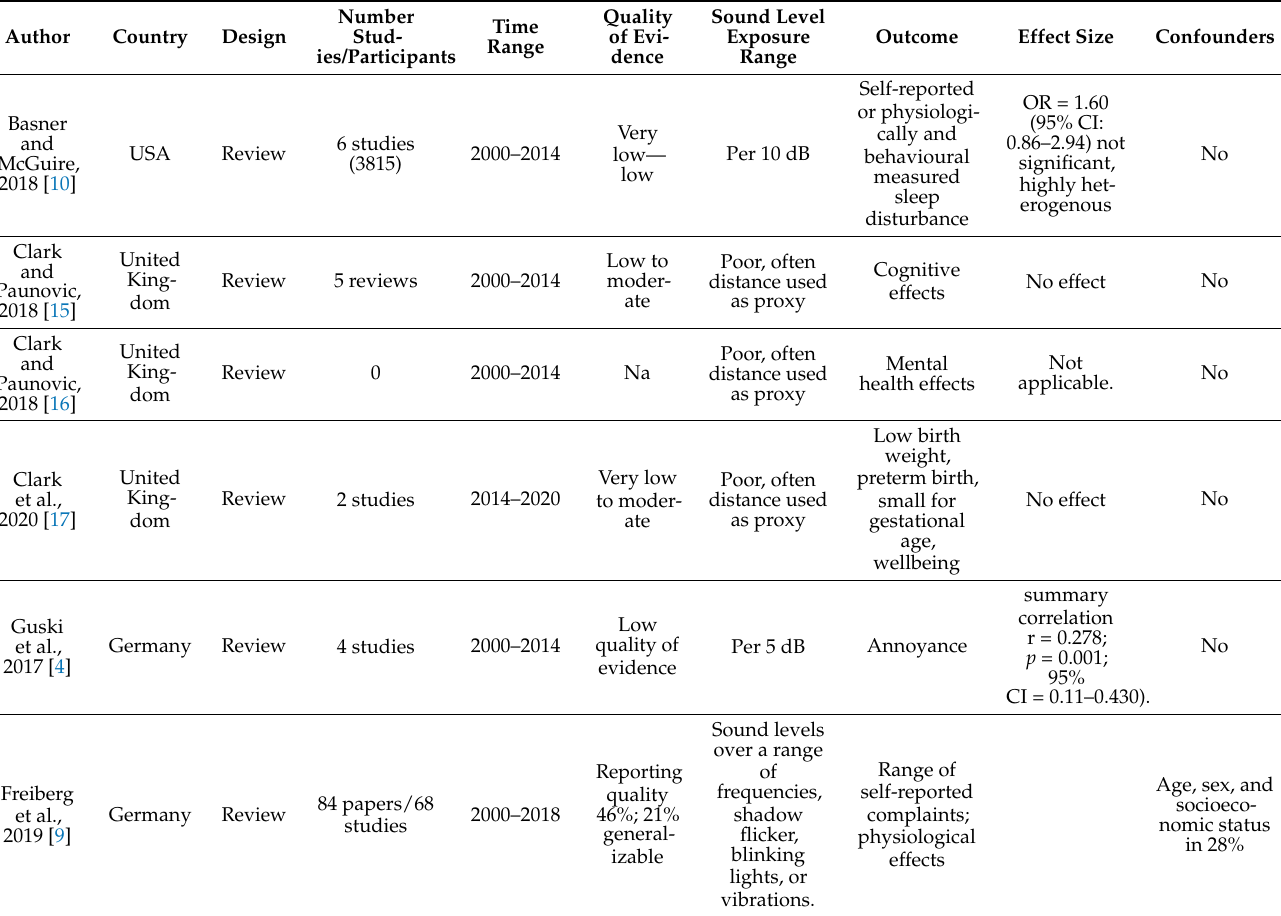
Table 1. Overview of the characteristics of the selected reviews on WT Sound and